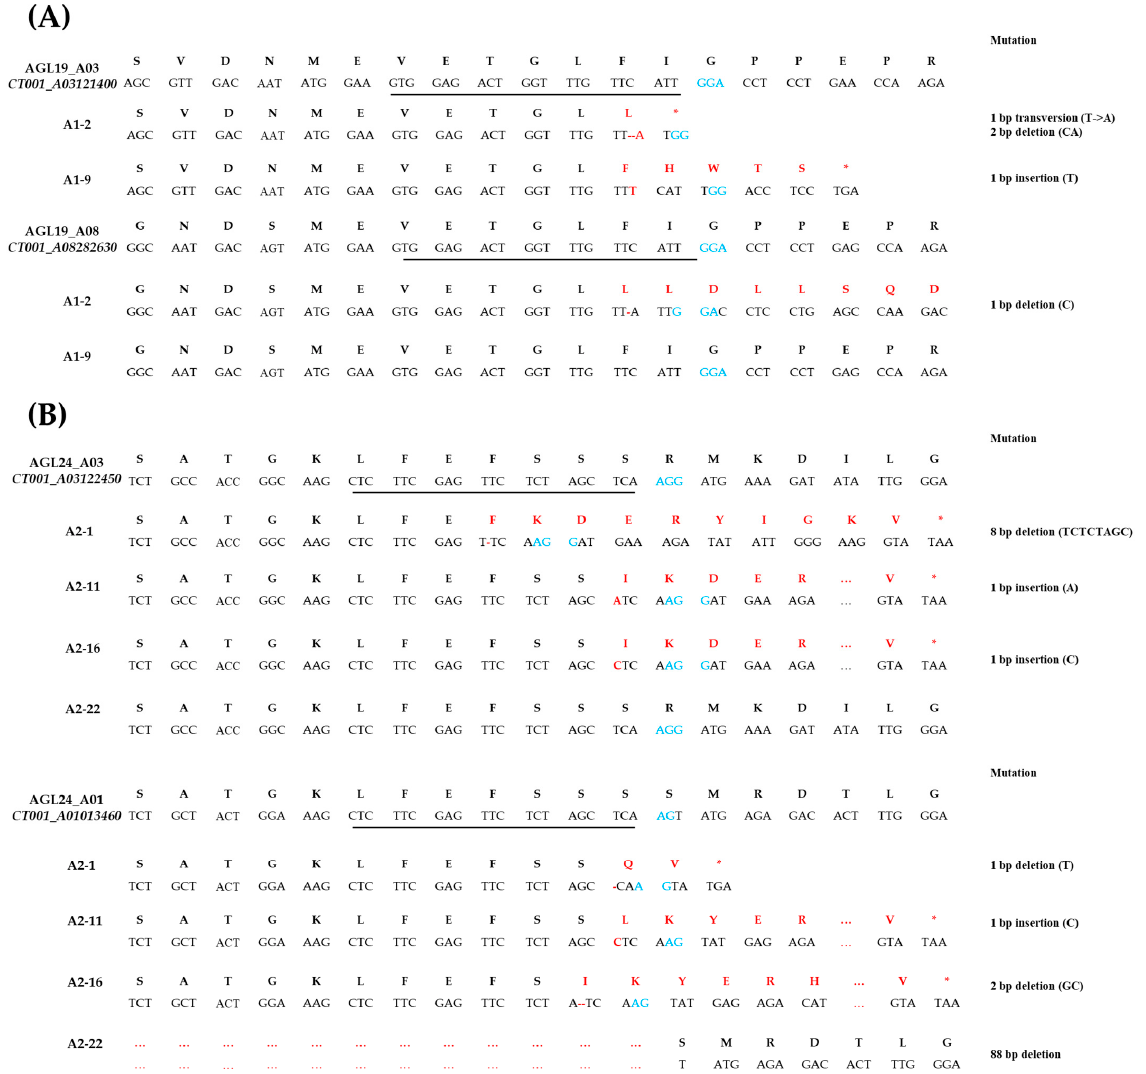
Figure 5. Mutagenesis patterns induced by clustered regularly interspaced short palindromic repeats (CRISPR)/Cas9 in E 0 gene-edited lines. ( A ) Comparison of each nucleic and amino acid sequence of AGL19 genes ( CT001_A03121400 and CT001_A08282630 ) in A1-2 and A1-9 lines. ( B ) Comparison of each nucleic and amino acid sequence of AGL24 genes ( CT001_A03122450 and CT001_A01013460 ) in A2-1, A2-11, A2-16, and A2-22 lines. The underline indicates single-guide RNA (sgRNA), and the blue font indicates the protospacer adjacent motif (PAM) sequence; the red font represents the presence of sequence mutations and the resulting change in the amino acid sequence; red star, stop codon.